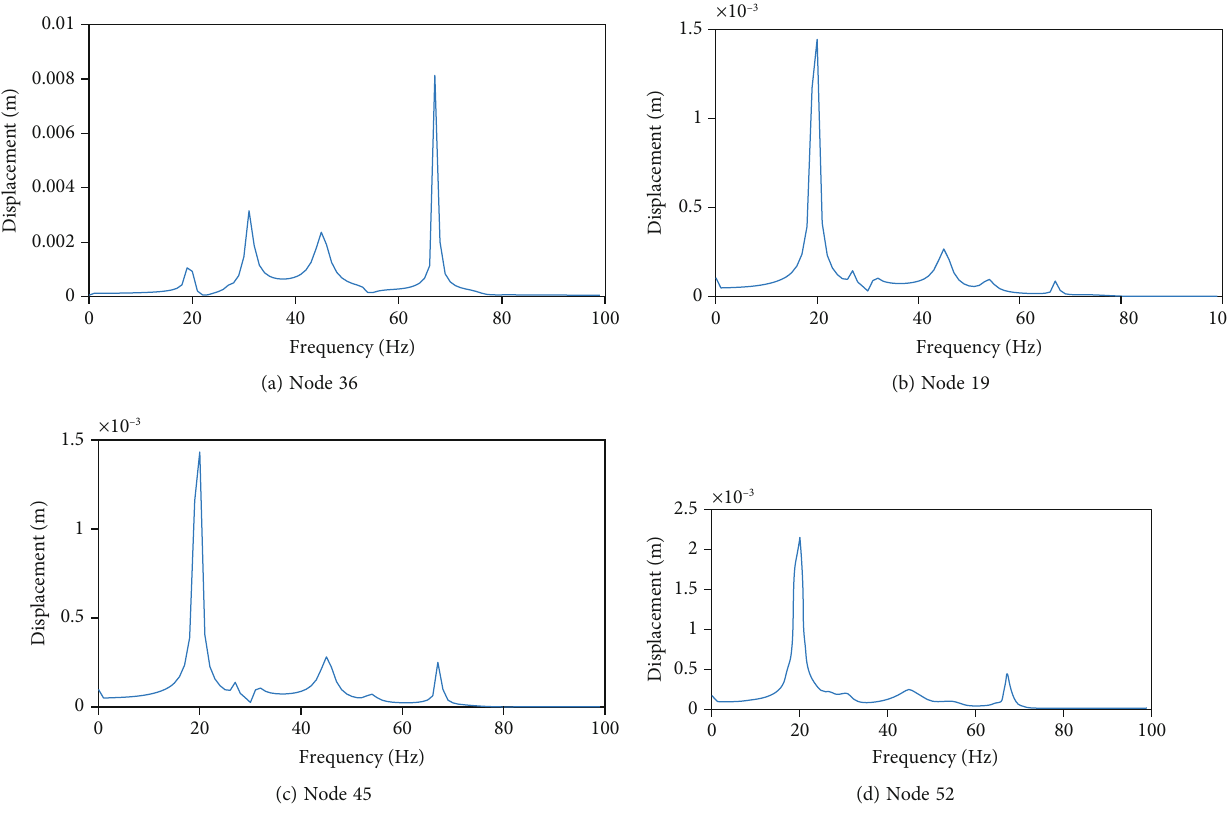
Figure 12: Response frequency analysis at key points in path